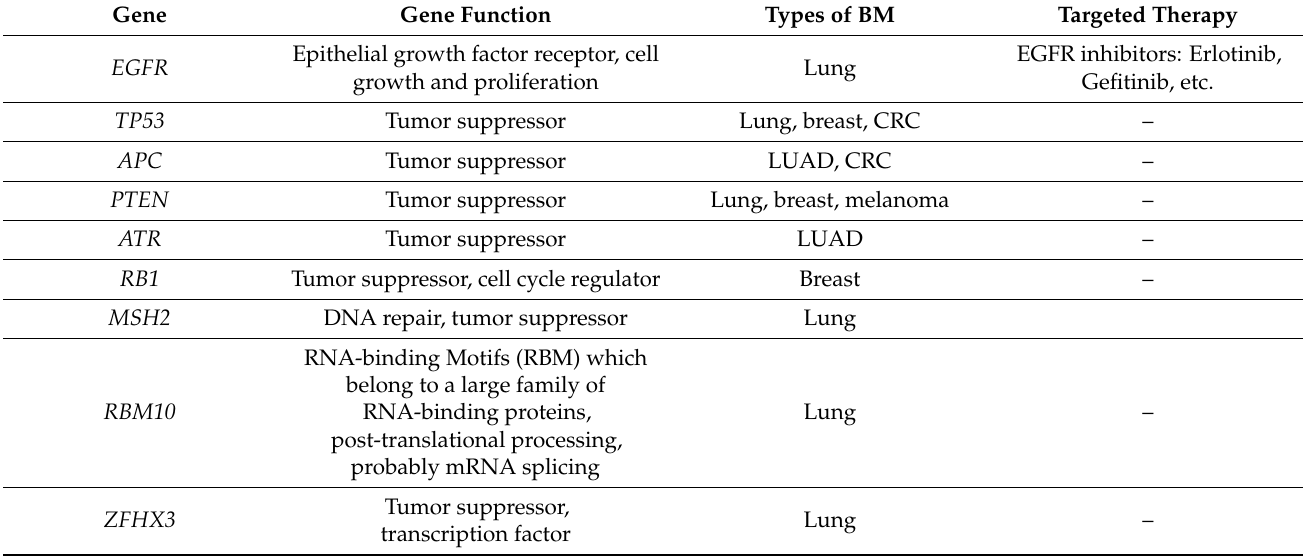
Table 2. Functions of significant genes in BM and available targeted therapies. Gene Gene Function Types of BM Targeted Therapy Epithelial growth factor receptor, cell EGFR growth and proliferation